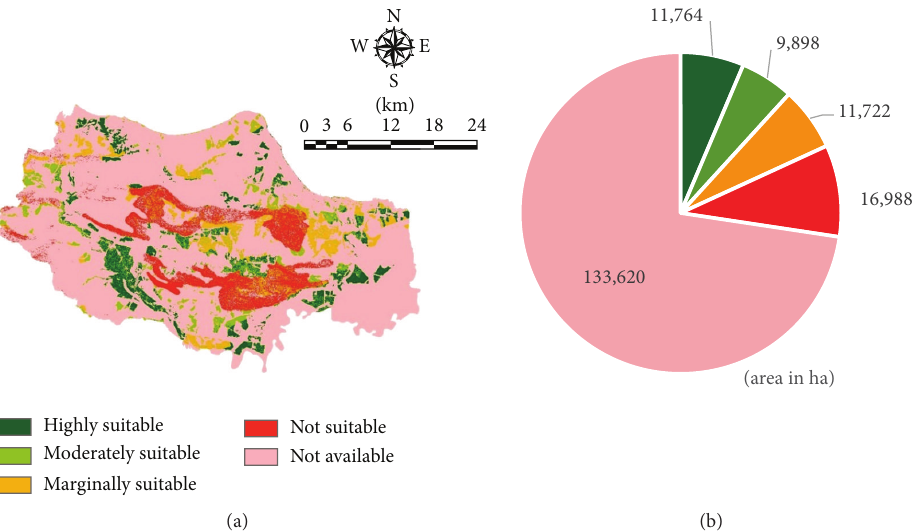
Figure7:Finalmap(a)andtotalarea(b)oflandwhichissuitableandavailableforagricultureinTubanRegencywhenconsideringconstraints from FASD and